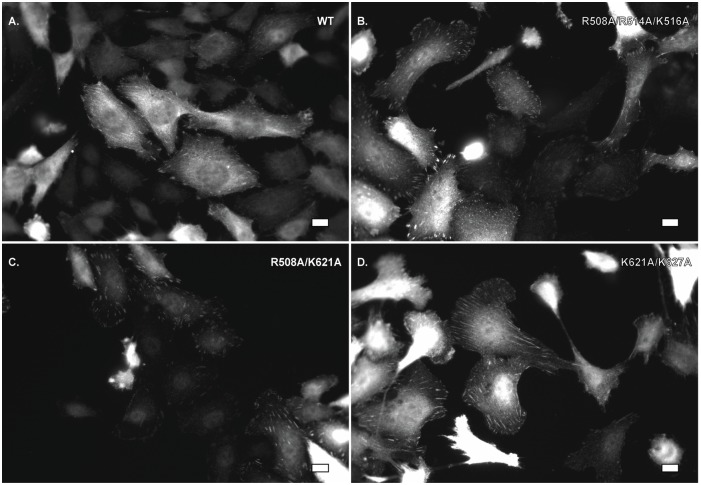
FAK catalytic domain mutants localize to focal adhesions.fak-/- MEFs expressing wild type or mutant FAK were plated on fibronectin coated cover slips overnight, fixed, permeabilized and incubated with the anti-FAK 4.47 monoclonal antibody. Alexa Fluor 488-labeled anti-mouse secondary antibody was utilized for visualization. Scale bar = 10 μm.